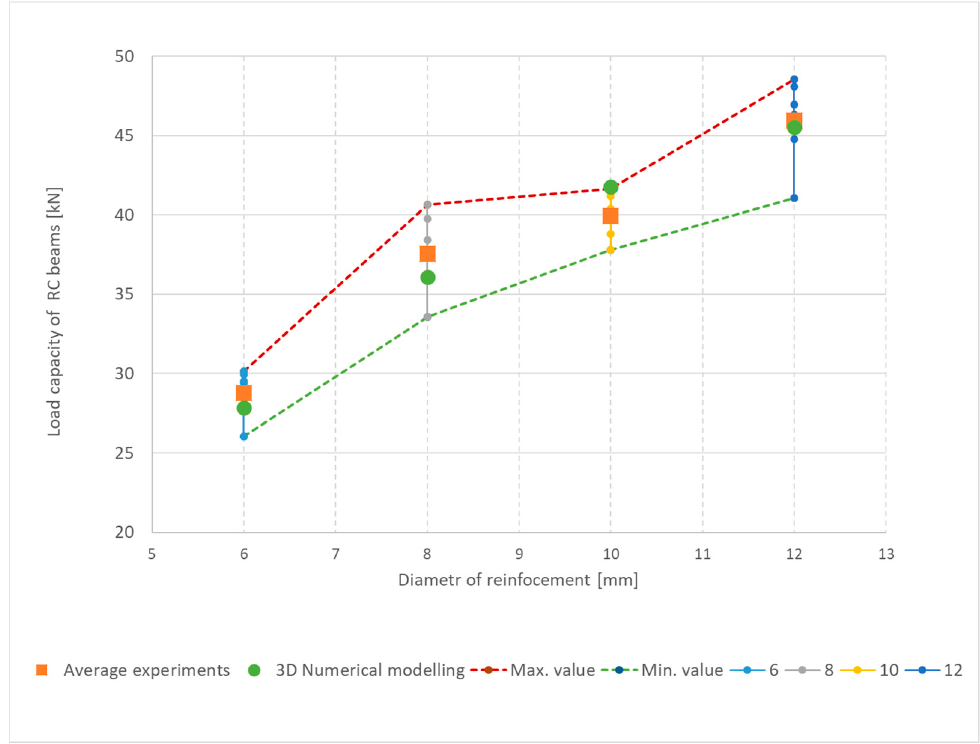
Figure 15. Summarized results for load capacity of reinforced concrete beams without transverse reinforcement.